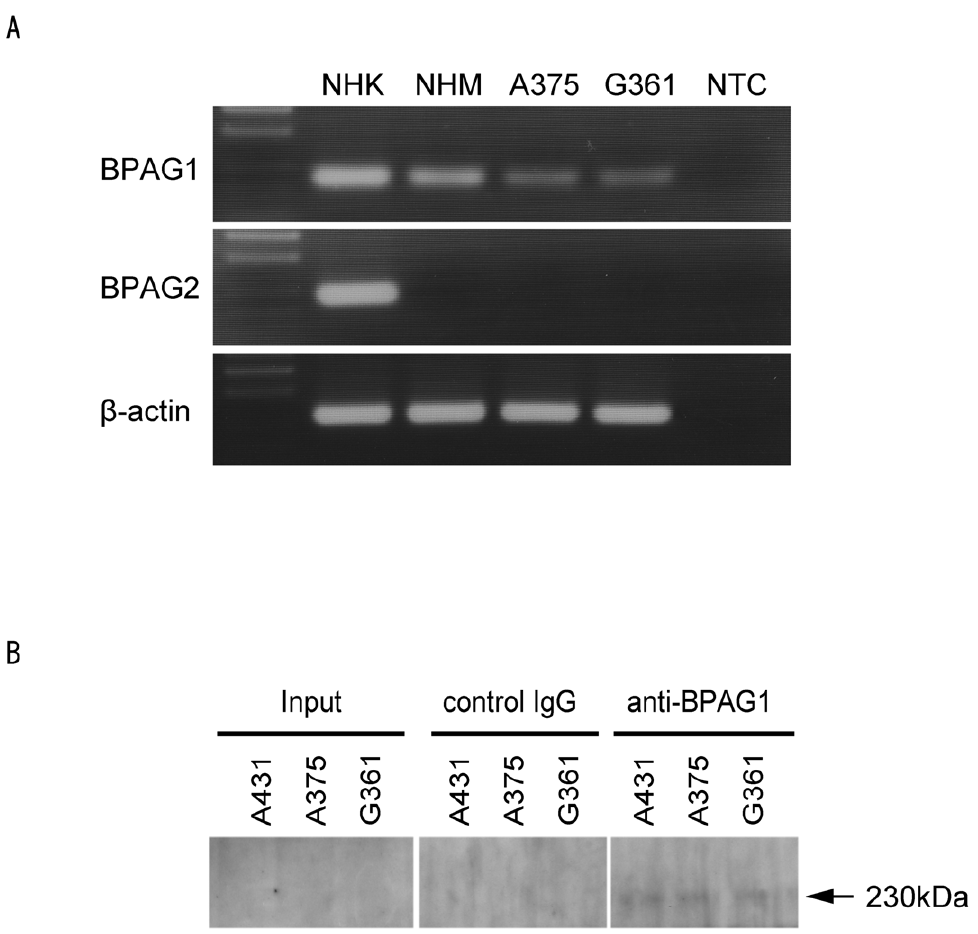
Figure 3. Expression of BPAG1 in normal human melanocytes and human melanoma cell lines. (A) The expression of BPAG1 and BPAG2 mRNA was quantified by RT-PCR in normal human melanocytes (NHM) and human melanoma cell lines A375 and G361. Normal human keratinocyte (NHK) mRNA was used as a positive control. b -actin was amplified as a loading control for cDNA. NTC; no template control. (B) The expression of BPAG1 protein was detected by IP-western blotting in human melanoma cell lines A375 and G361. A431 was used as positive control for BPAG1. The arrow indicates BPAG1.